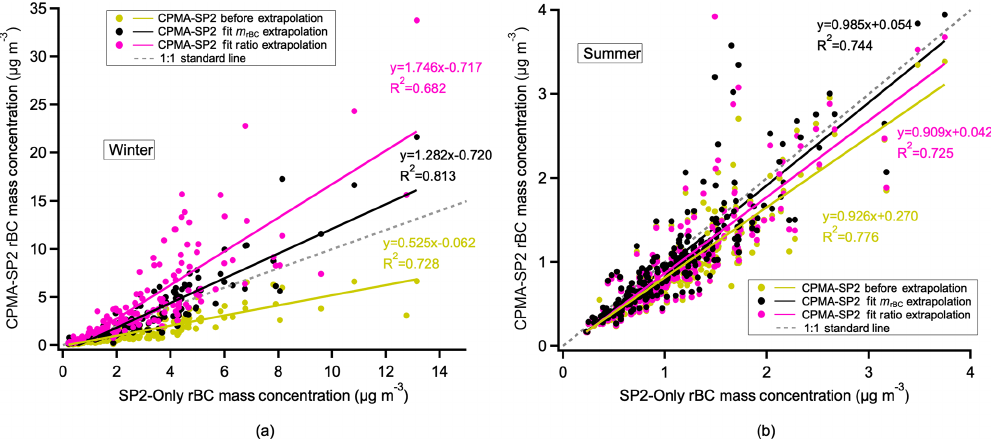
Figure 2. The rBC mass concentration comparison between the SP2-only measurement and two different CPMA–SP2 extrapolation methods in winter (a) and summer (b) .